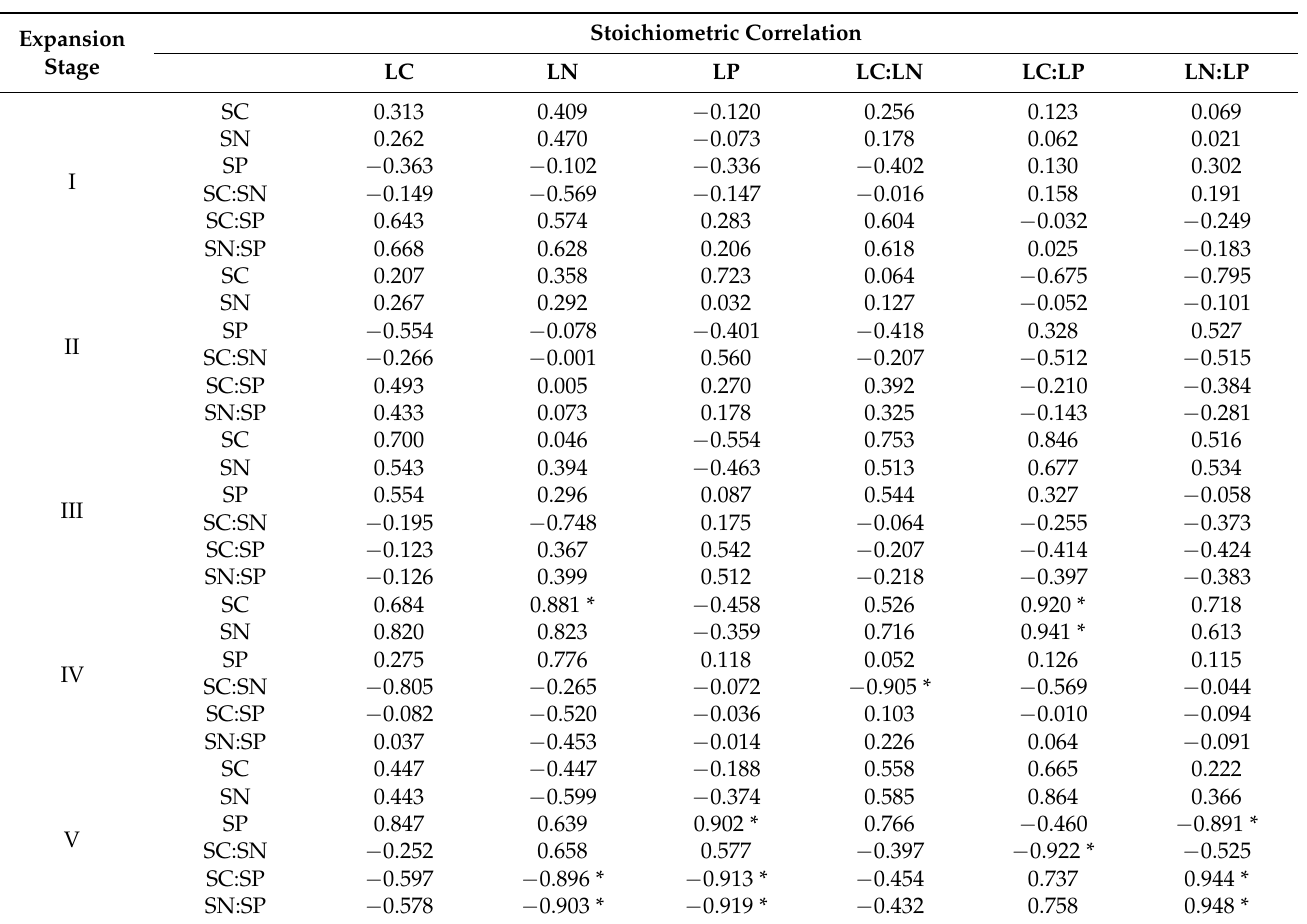
Table 2. Correlations of stoichiometry and stoichiometric ratios between the leaf and soil at different stages of Moso bamboo expansion into Chinese fir forests.